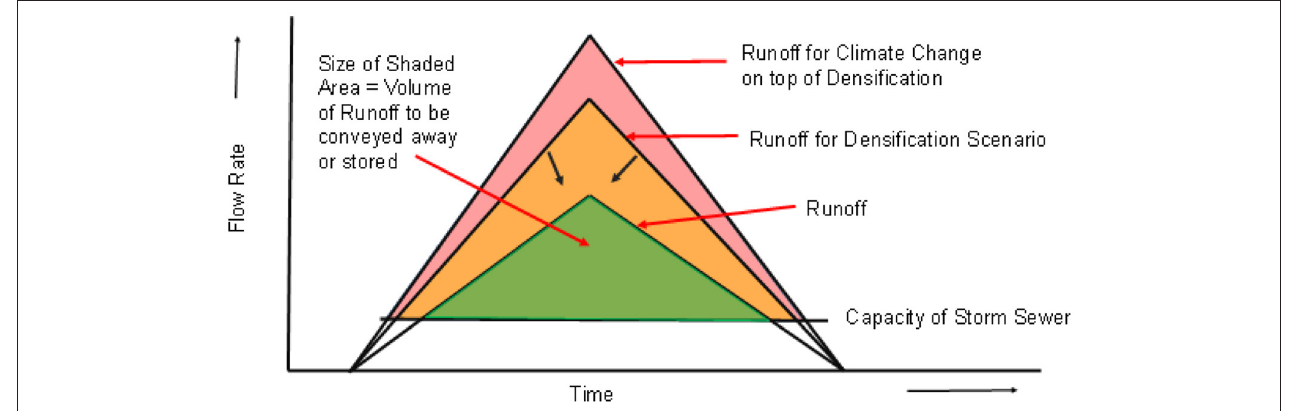
FIGURE 5 | Impacts of Densification and Climate